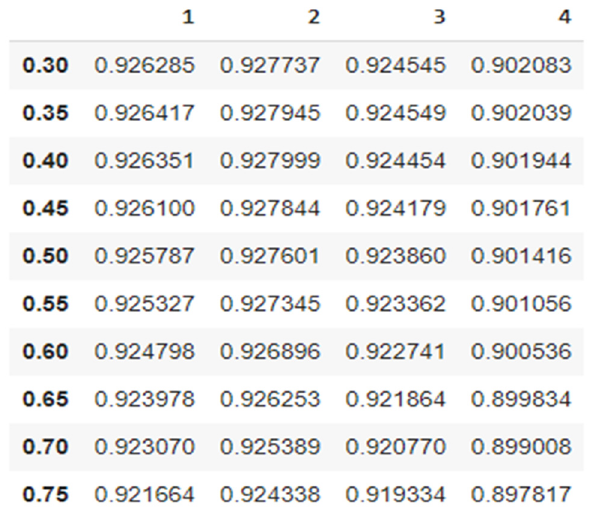
Figure 12. Fourfold obtained dice for different chosen thresholds.